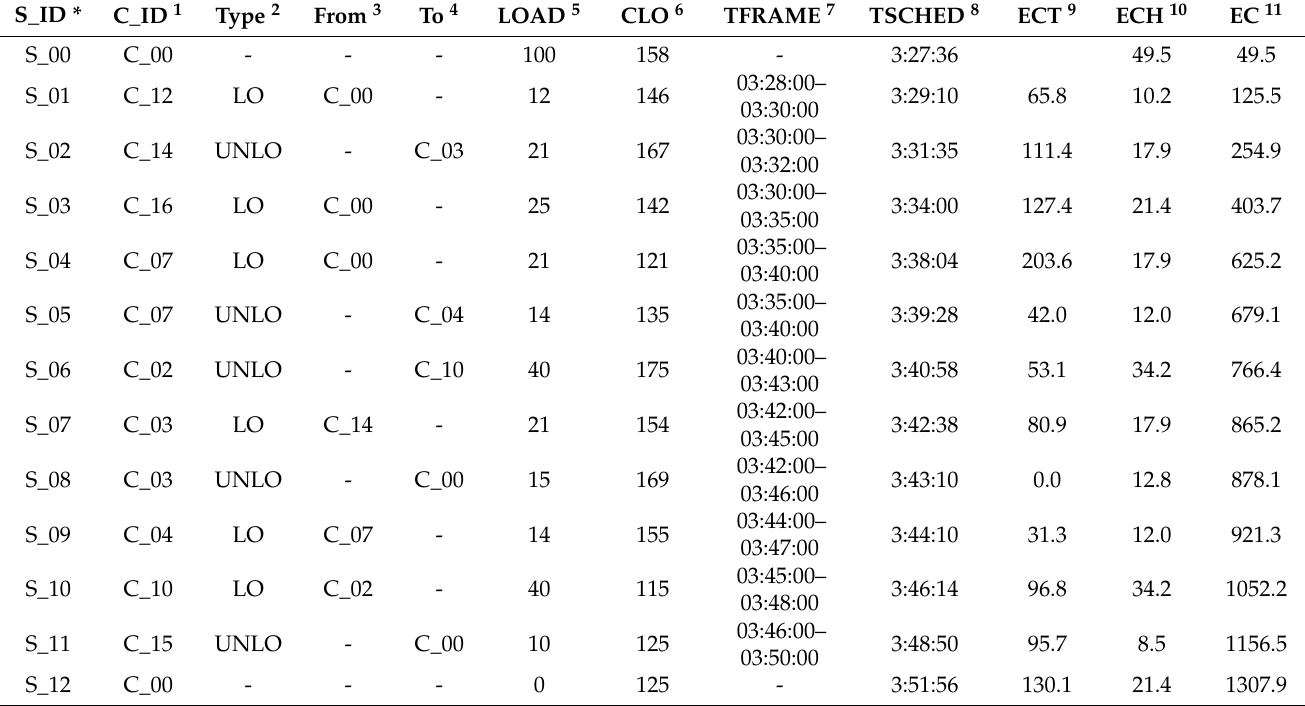
Table 3. Numerical results of the scheduling of predefined specific in-plant material supply operations performed by the milk-run trolley within route